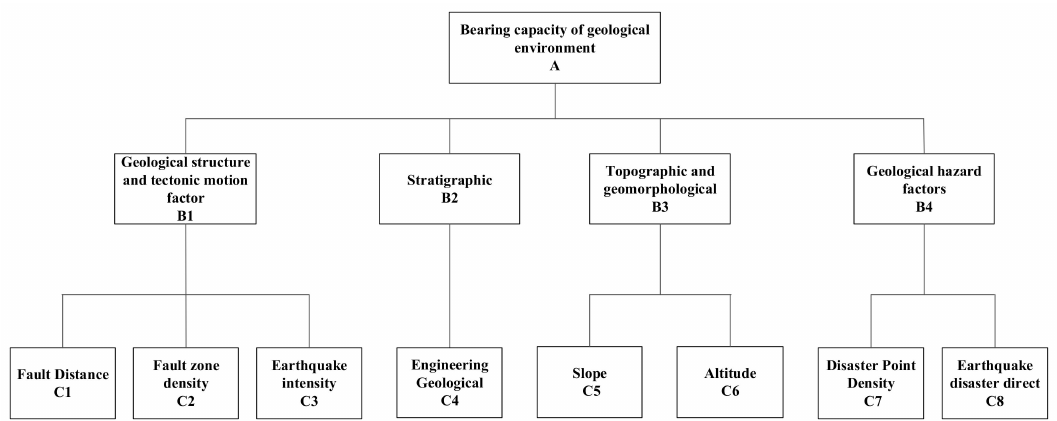
Figure 6. Hierarchical structure of geological environment bearing capacity evaluation.